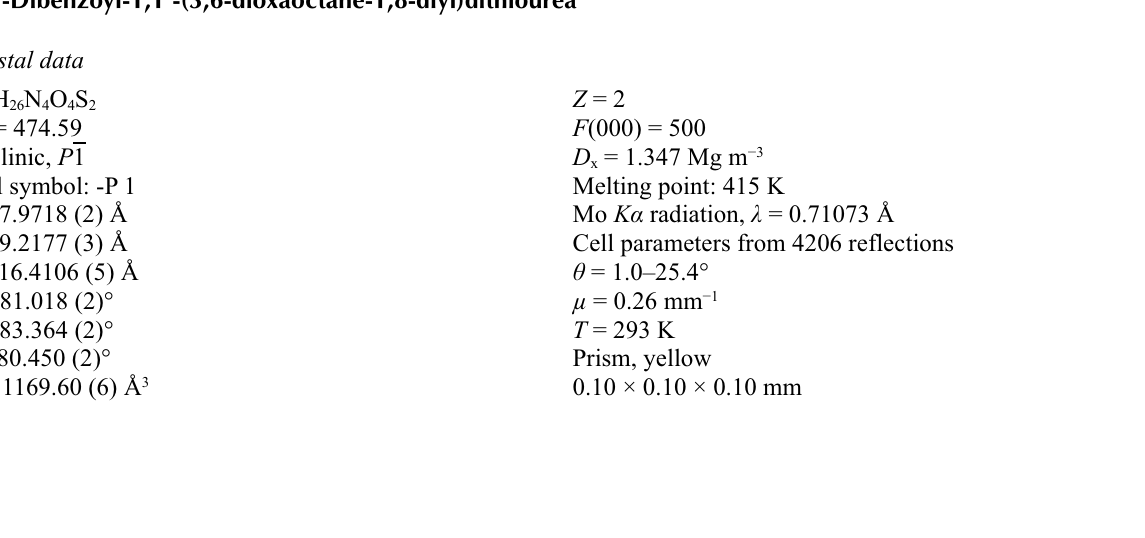
Molecular representation of the compound showing hydrogen bonds (dashed